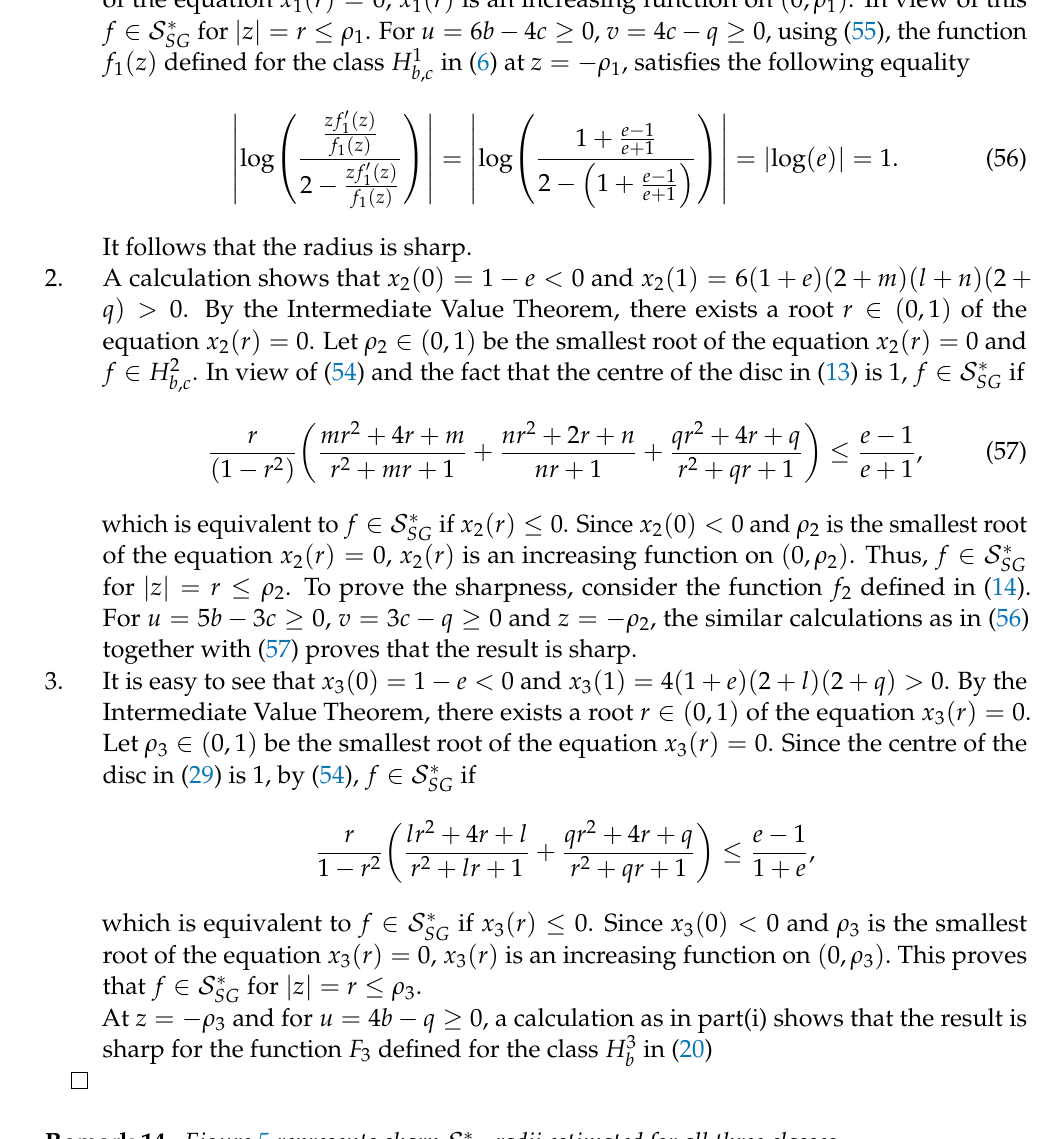
radii for H 1 SG